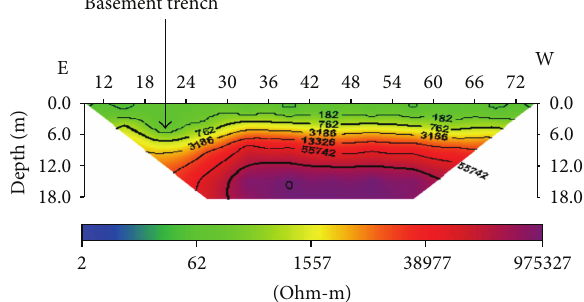
Figure 6: Inverted 2D resistivity structure along TR3. The fracture paths appear to have died out completely at the downstream end, but a basement trench in the eastern limit of the traverse is